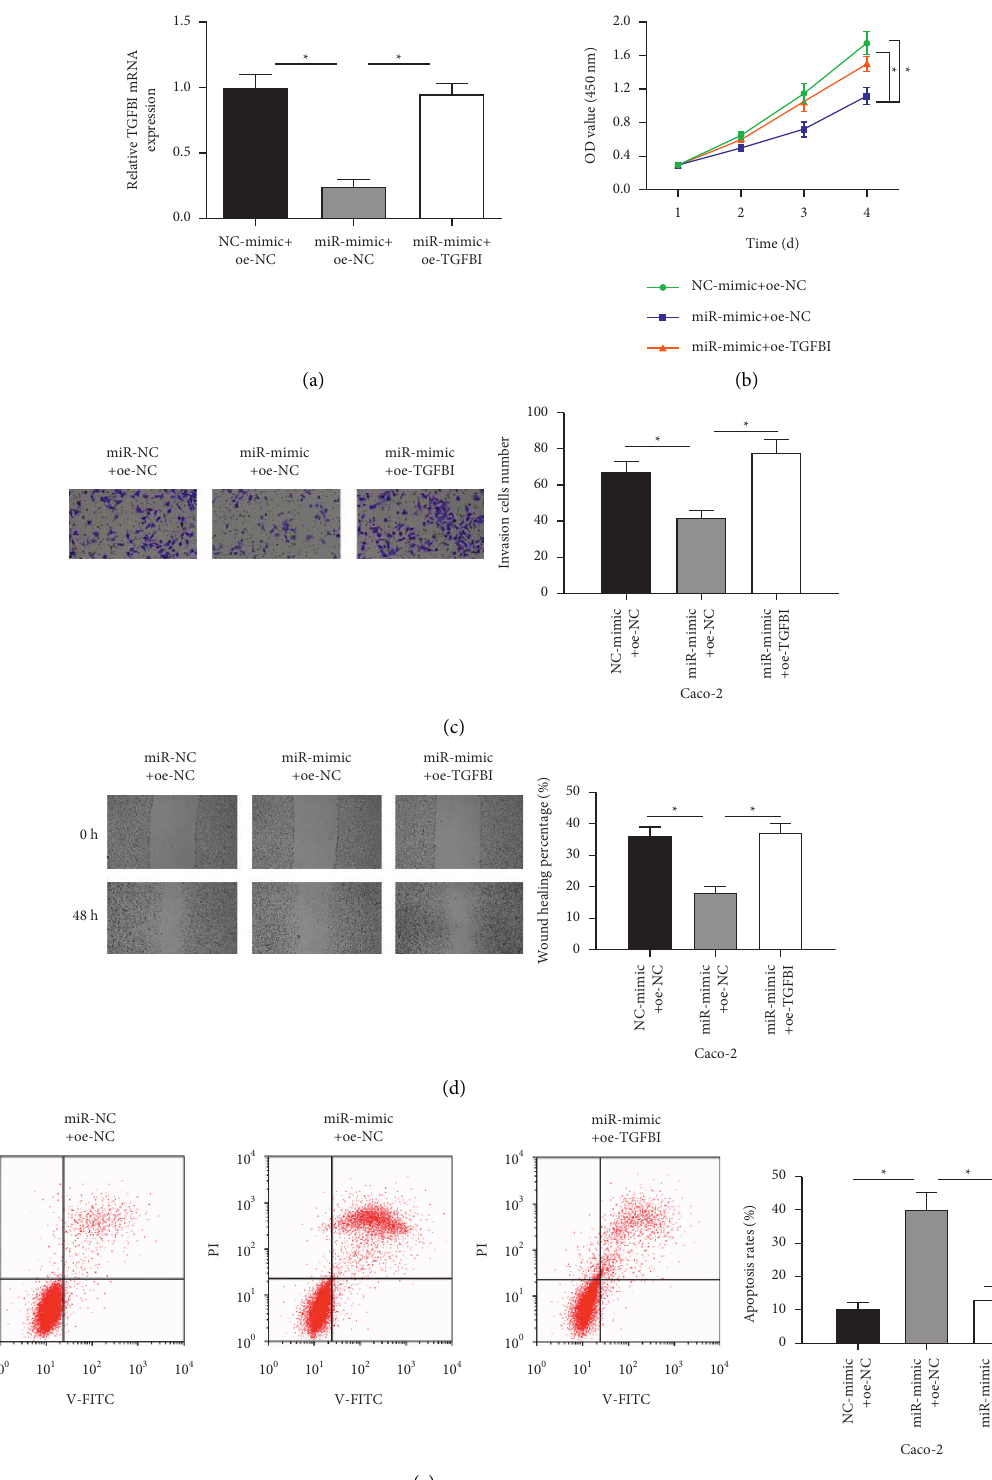
Figure 4: MiR-766-3p hampers cell malignant behaviors and stimulates cell apoptosis in colon cancer by downregulating TGFBI. (a) TGFBI mRNA expression in colon cancer cells Caco-2 (miR-NC+oe-NC, miR-mimic+oe-NC, and miR-mimic+oe-TGFBI). (b) Proliferation of Caco-2 cells. (c) Invasion of Caco-2 cells (100 × ). (d) Migration of Caco-2 cells (40 × ). (e) Apoptosis level of Caco-2 cells. ∗ P < 0 .